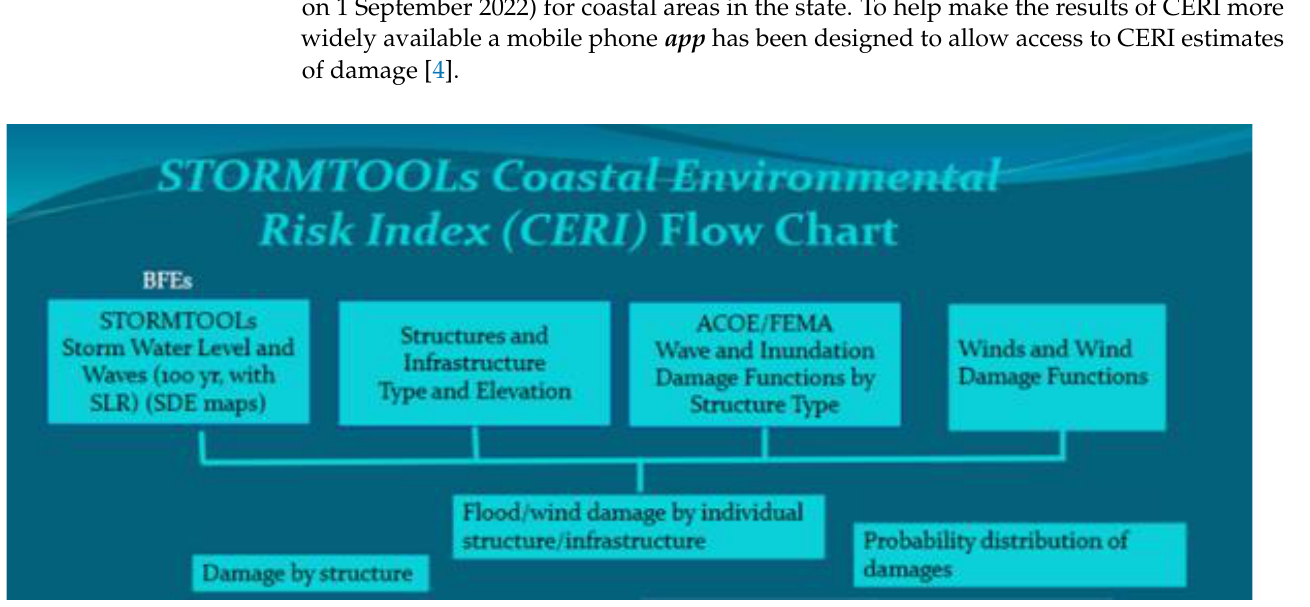
Figure 1. STORMTOOLS Coastal Environmental Risk Index (CERI) flow chart [1].